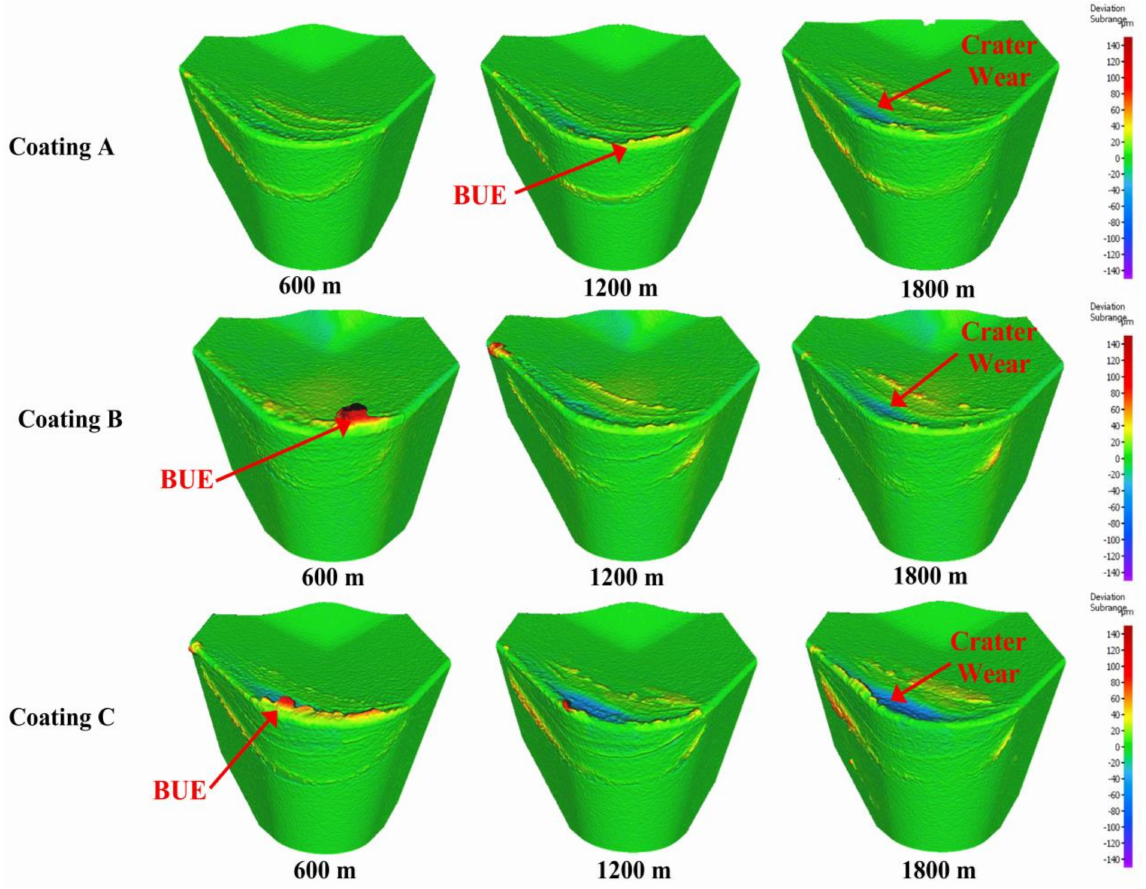
Figure 2. 3D progressive wear difference measurement of the coated tools highlighting evolution of built − up layer and crater wear during